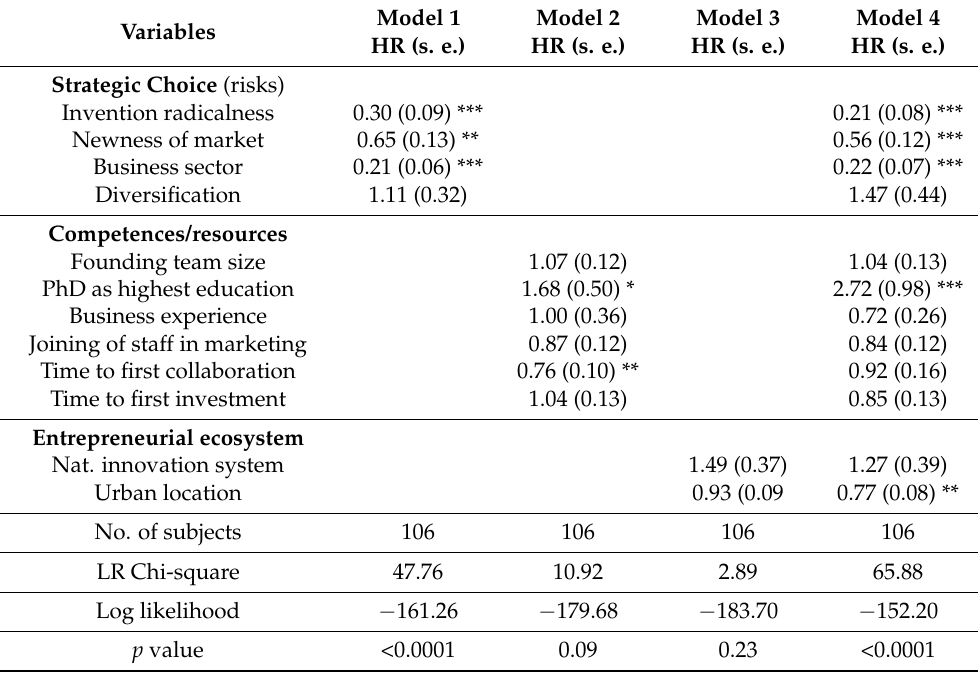
Table 2. Cox Regression Results on Time to